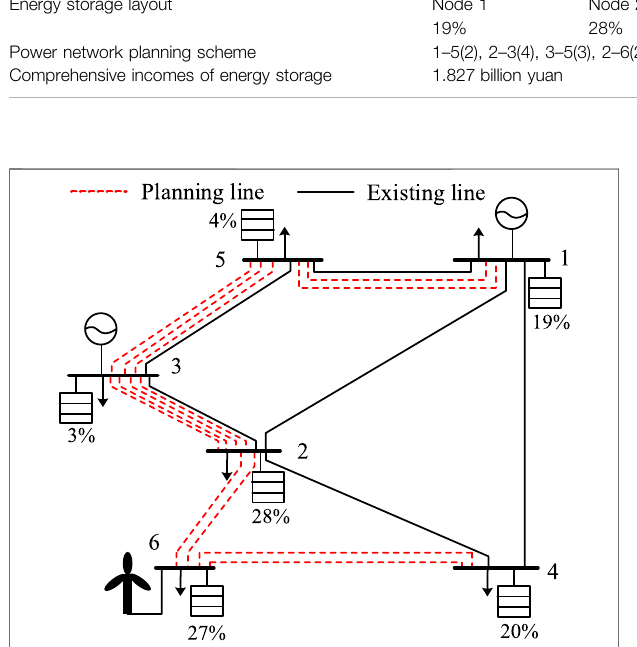
FIGURE 9 | Power grid planning scheme under fi xed time-of use- electricity price.